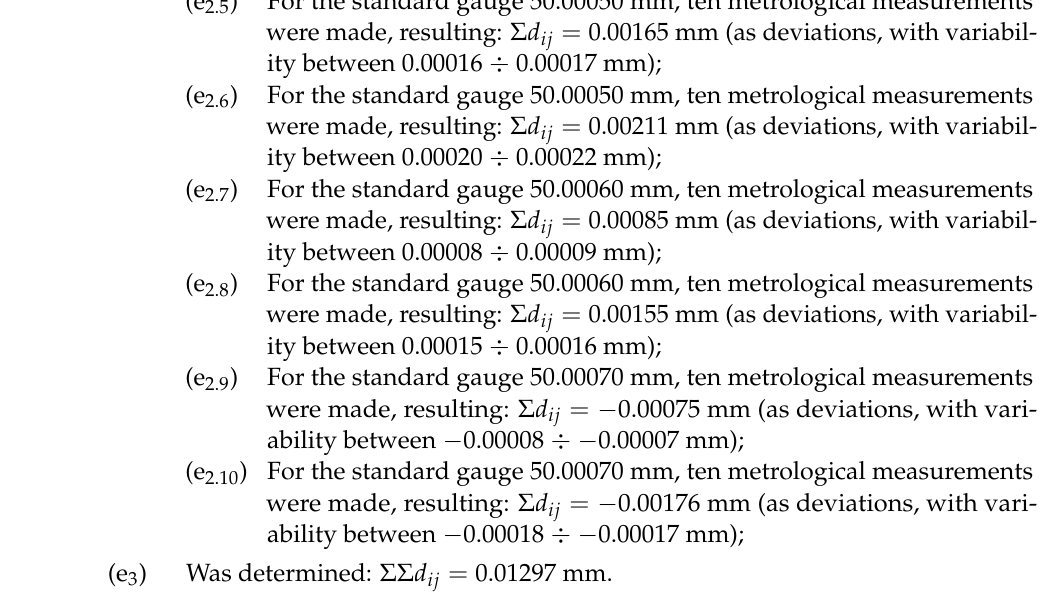
Table 6. Protocol of metrological measurements for determination of metrological values